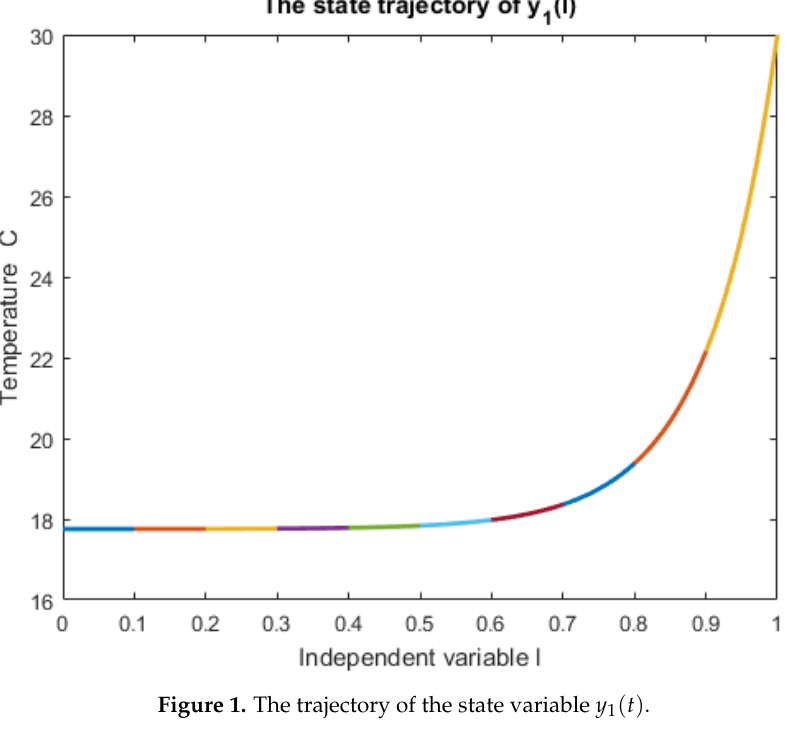
Figure 1. The trajectory of the state variable y 1 ( t ) .